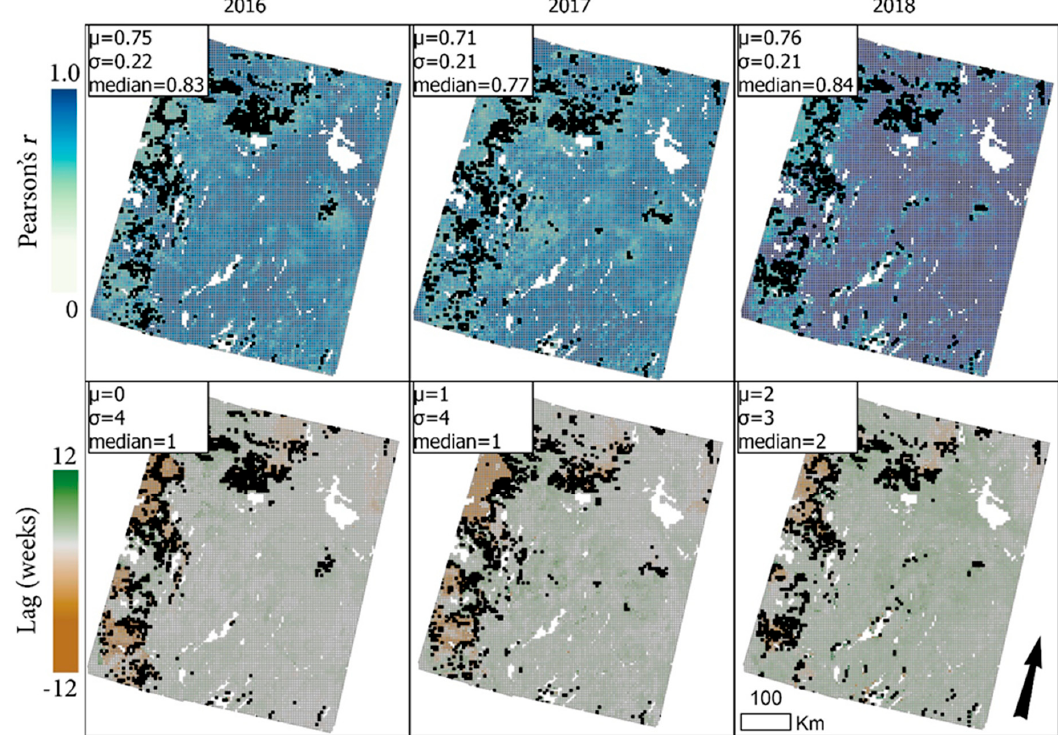
Figure 3. Cross-correlation and lag statistics between eMODIS and regression tree estimated Normalized Difference Vegetation Index (NDVI) as summarized across all 5 × 5 km grids during 2016–2018. Time series were populated using NDVI values within target land cover types (i.e., rangelands and evergreen forests). Areas with insignificant correlations ( p -value > 0.05) and mostly non-target land covers are shown as black and white grids, respectively. A positive (negative) lag indicates that eMODIS NDVI lags (leads) that of HLS RT NDVI. Table 2. Cross-correlation (Pearson’s r ) between eMODIS, regression tree estimated (HLS RT ), and interpolated harmonized Landsat and Sentinel-2 (HLS int ) data within rangelands stratified by level III ecoregions [28]. Bold values indicate r ’s greater than adjacent r values. Ecoregions substantially impacted by snowfall (i.e., Cascades, Sierra Nevada) are excluded from overall summaries. % Study eMODIS Ecoregion Area Year and HLS RT (r l )